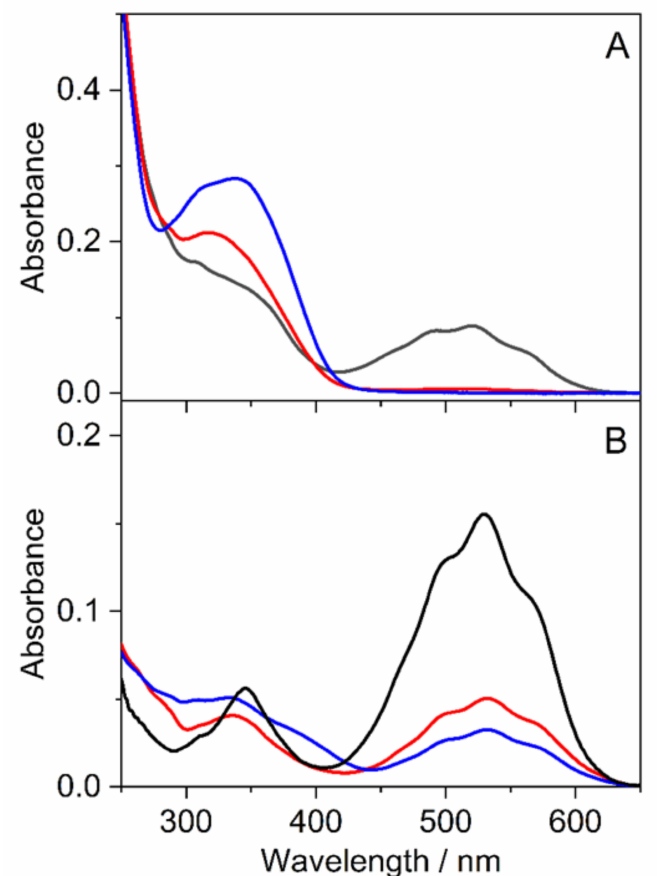
Figure 9. Absorption spectra of 7 ( A ) and 5 ( B ) immediately after the preparation of the samples in water (black lines) and in 20.84 mg/mL SBECD aqueous solution (red lines). Blue lines represent the spectra of the latter solutions in 3